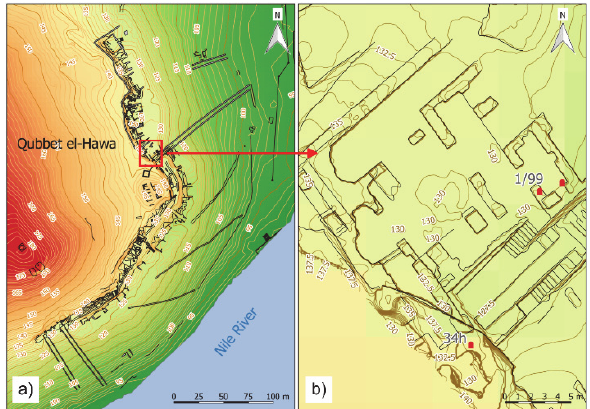
Figure 1. Location of the Qubbet el-Hawa Coptic Church